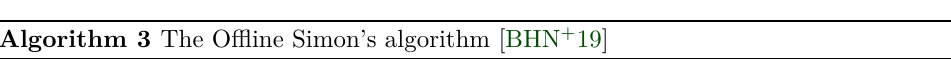
Algorithm 3 The Offline Simon’s algorithm [BHN +